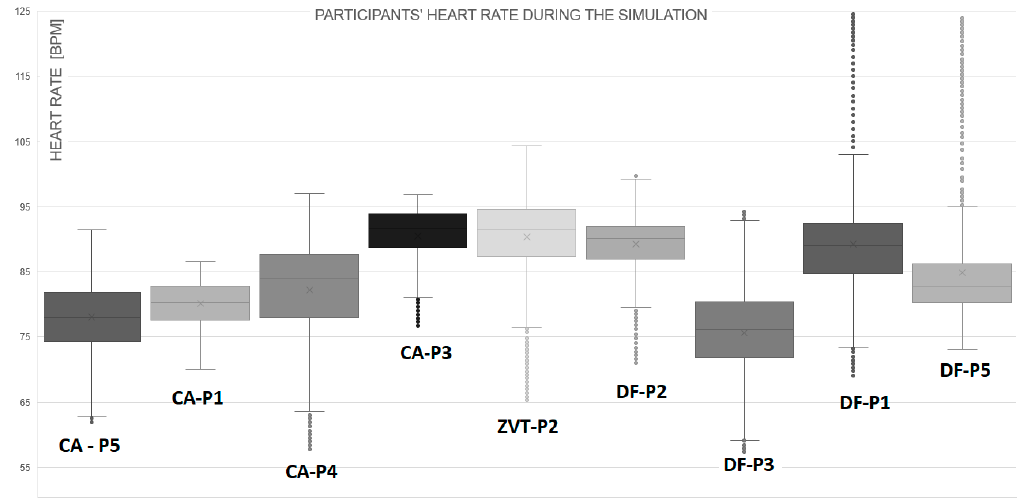
Figure 6. HR parameters during 20 min simulated navigational task. CA—collision avoidance task, ZVT—zero visibility task, DF—Disturbing factor task, P—participant.